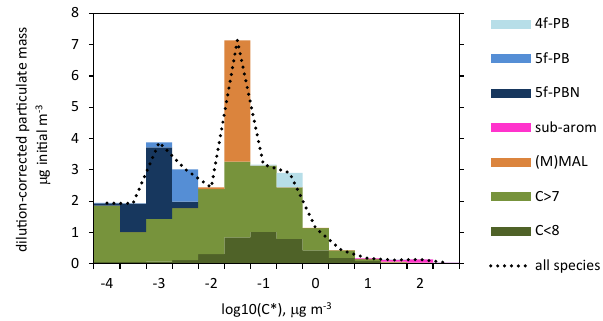
Figure 8. Chemical composition of the particle phase at the end of the urban outflow simulation, distributed by volatility. Colors show species groupings as discussed in the text: “C<8” and “C>7”, lin- ear/branched molecules separated by carbon number (no distinc- tion for nitrate is made here); “(M)MAL”, substituted maleic an- hydrides; “sub-arom”, substituted rings that retain aromaticity; “5f- PBN”, PBAs with five-functional groups including nitrate; “5f-PB”, as 5f-PBN without nitrate; “4f-PB”, PBAs with four-functional groups. Dotted line shows total particle-phase mass. The leftmost bin also includes the mass from species with log 10 (C ∗ ) < −